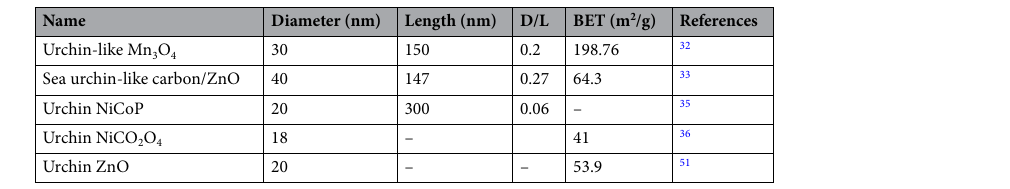
Table 7. Comparison of nanourchin-like